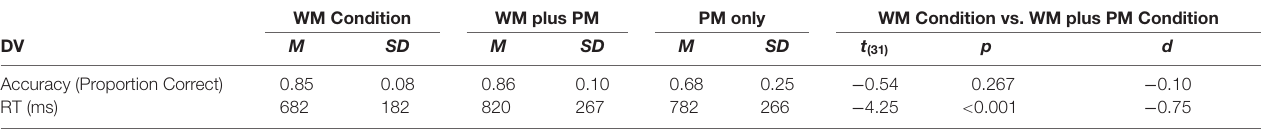
TABLE 2 | Mean RTs (ms) and accuracy (proportion correct) for task conditions in ongoing WM and PM task parameters. WM Condition PM only WM Condition vs. WM plus PM Condition